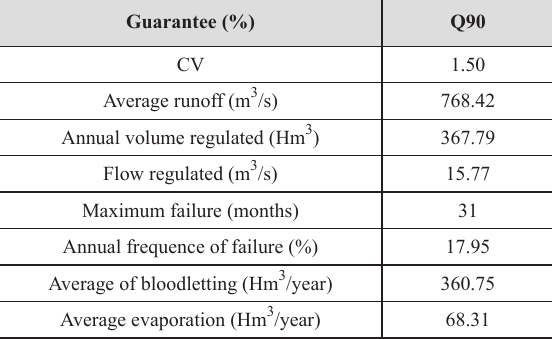
Guarantee coefficients (Ceará